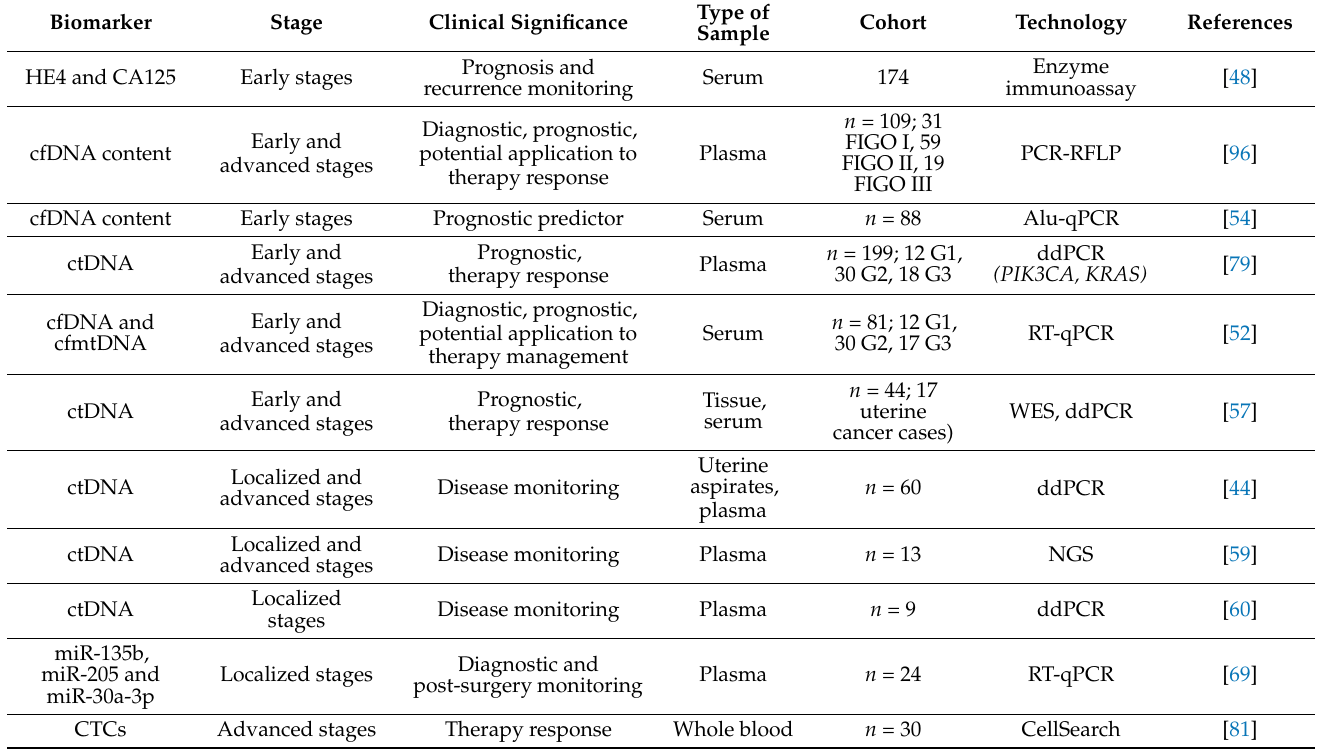
Table 1. Summary of studies characterizing circulating biomarkers to monitor